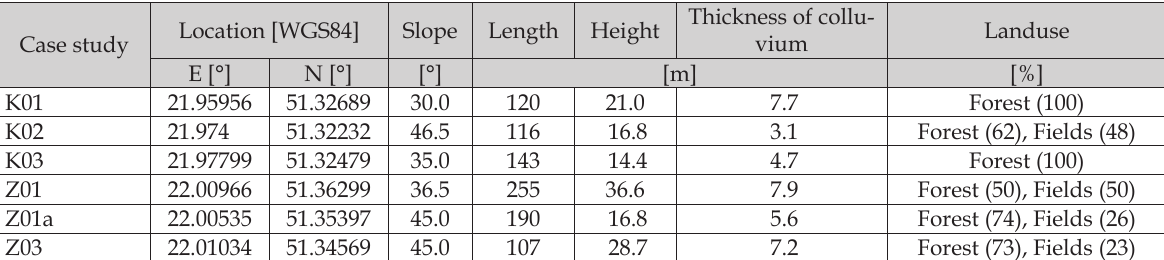
Table 1. Parameters of research slopes.